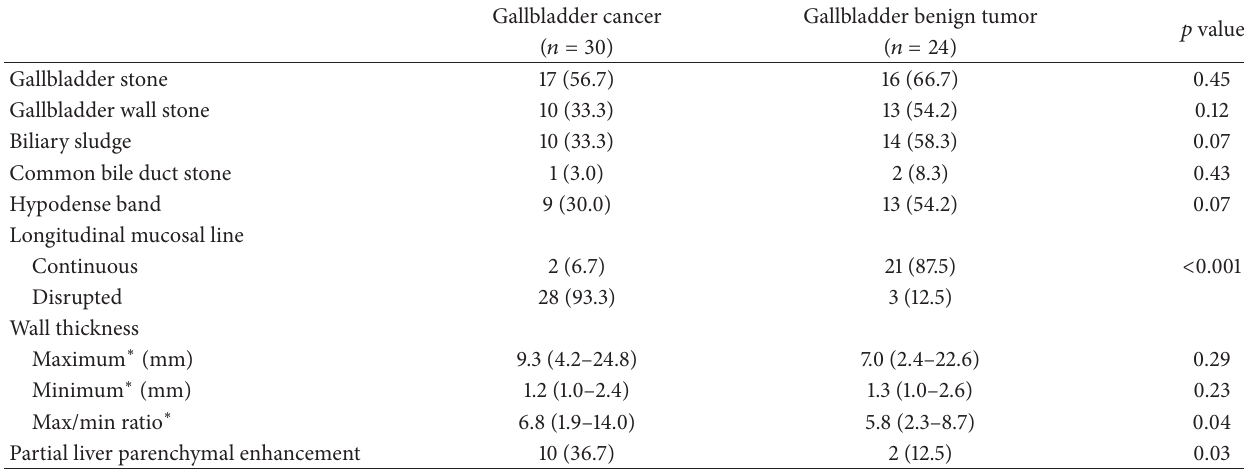
Table 2: Longitudinal MPR image analysis.